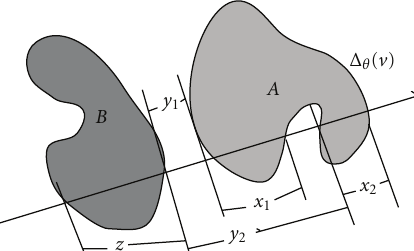
Figure 1: Oriented line Δ θ ( v ), segment as in B , longitudinal section as A